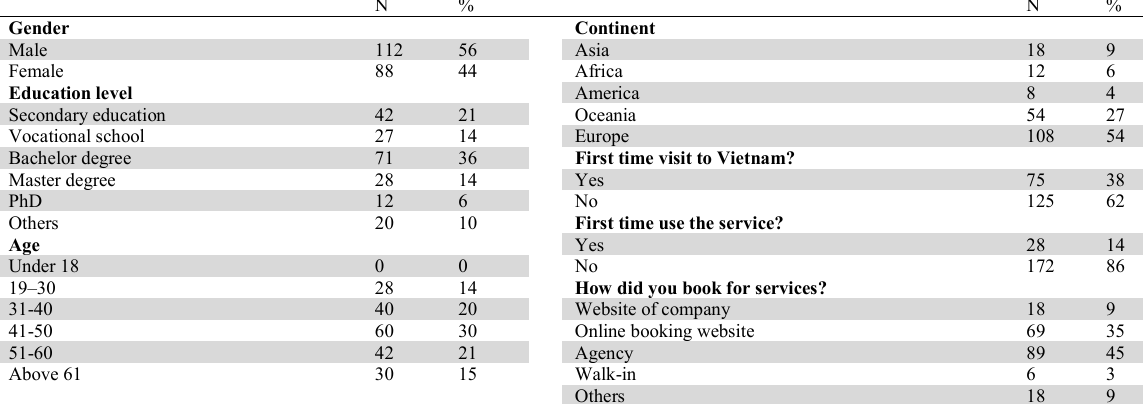
Demographics of customers